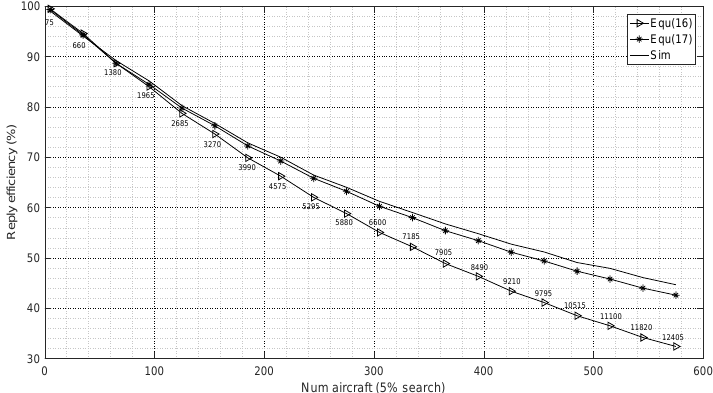
Figure 5. Number of aircraft vs. reply efficiency.